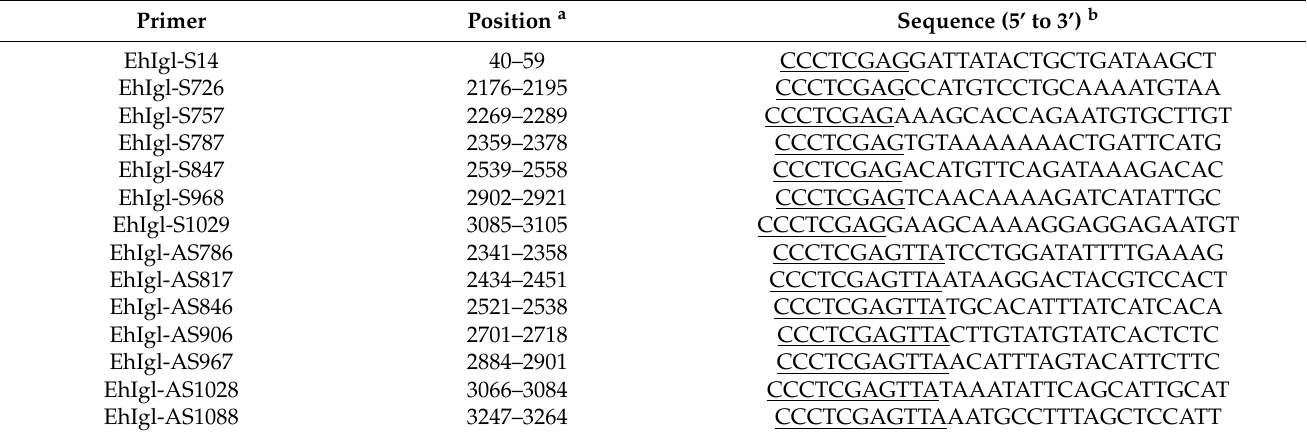
a Nucleic acid numbering is based on the E. histolytica Igl1 gene sequence (AF337950). b Nucleotides added for cloning and translation termination are